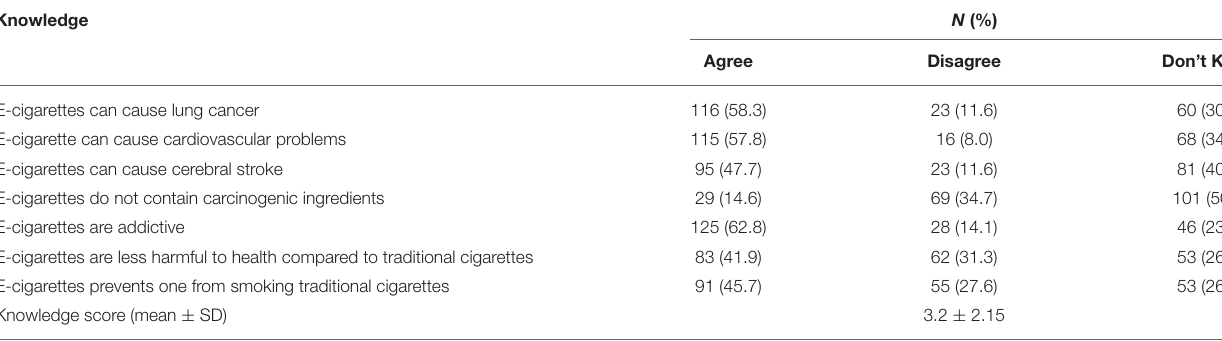
TABLE 2 | Knowledge about e-cigarettes among all